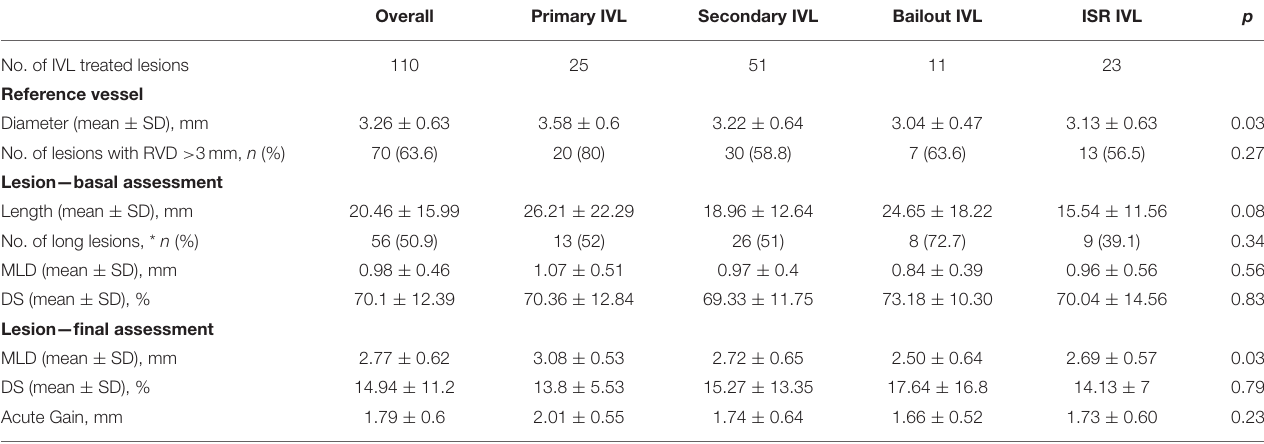
TABLE 4 | Quantitative coronary angiography of treated lesions in the overall population and patient subgroups.